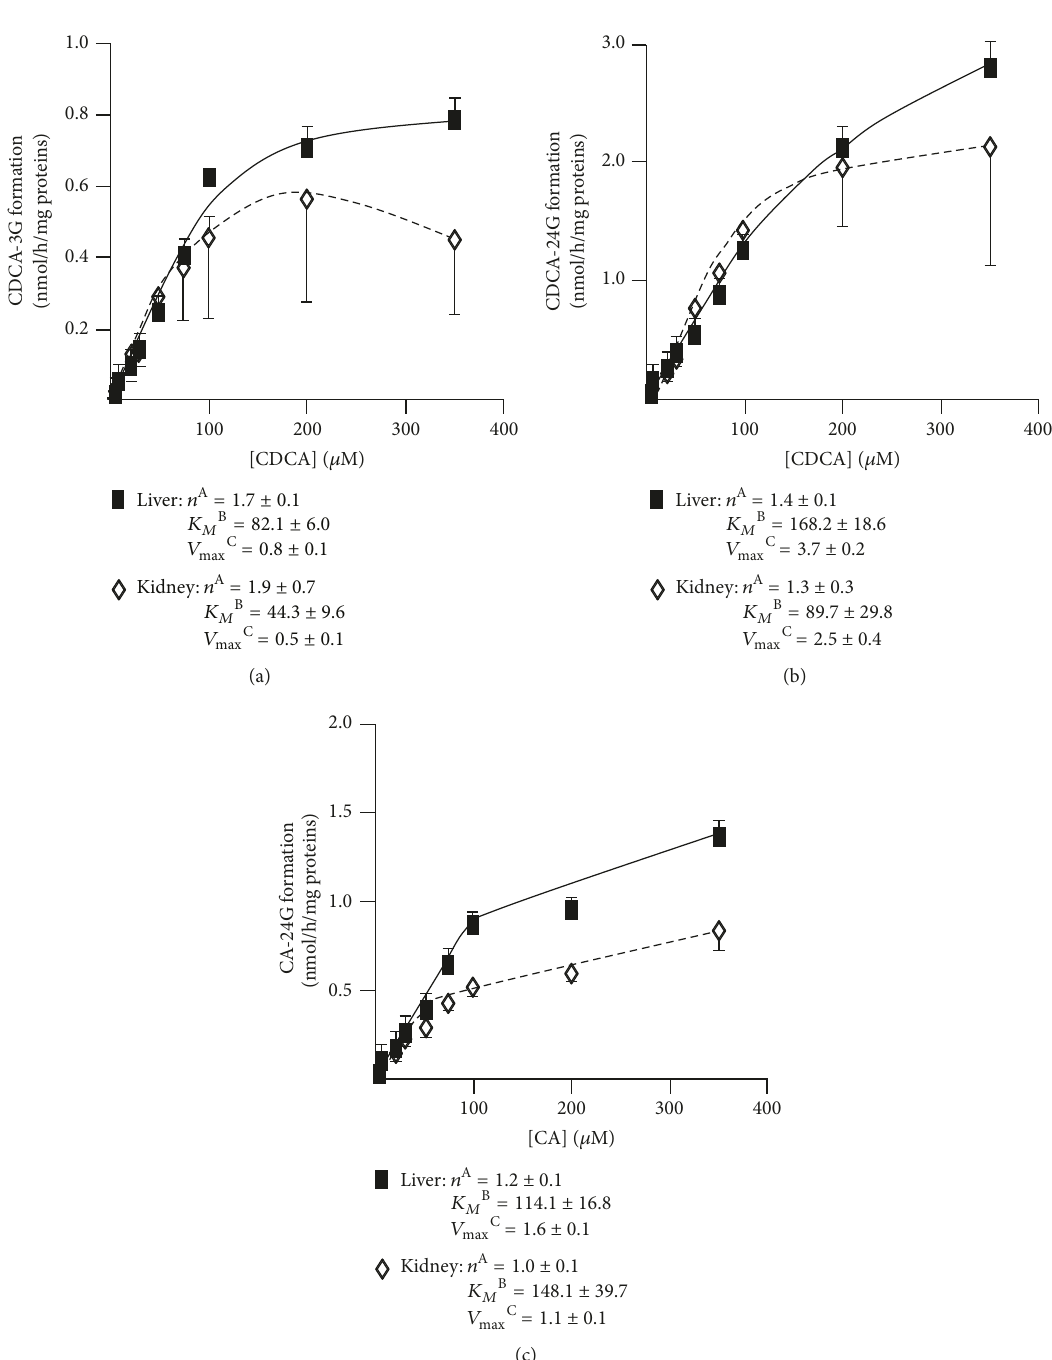
Figure 3: Kinetic analyses of CDCA-3G (a), CDCA-24G (b), and CA-24G (c) formation by microsomes from human liver and kidney. Human liver (black squares, pool of 50 donors) and kidney (white diamonds; pool of 8 donors) microsomes (10 𝜇 g) were incubated in the presence of increasing concentrations (1 to 350 𝜇 M) of chenodeoxycholic acid (CDCA, (a) and (b)) or cholic acid (CA, (c)) for 2 hours at 37 ∘ C. The formation of CDCA-3G (a), CDCA-24G (b), and CA-24G (c) was analyzed by LC-MS/MS. For each panel, graphs represent the rate of product formation ( 𝑦 -axis) versus substrate concentration ( 𝑥 -axis) of two experiments performed in triplicate. The listed kinetic parameters were determined as indicated in “Materials and Methods.” A 𝑛 : Hill coefficient; B 𝐾 𝑀 : calculated Michaelis constant expressed as 𝜇 M; C 𝑉 max : calculated maximal velocity expressed as nmol/h/mg